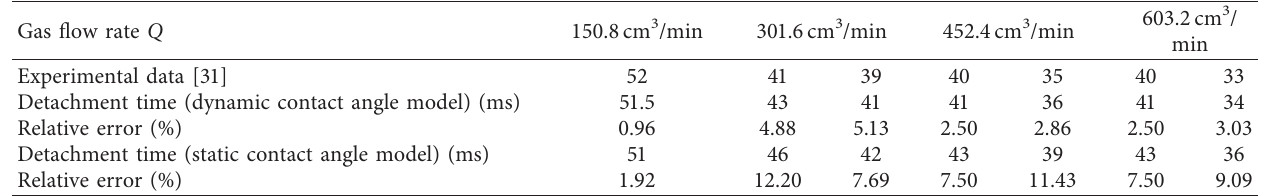
Figure 15: Snapshot comparison of bubble formation ( Q � 603.2cm 3 /min, Re � 219.07, and d � 4mm): (a) experimental snapshots [31]; a (b) results of dynamic contact angle model simulation ( θ A � 130 ° and θ R � 84 ° ); (c) results of static contact angle model simulation ( θ C � 100 ° ). Table 2: Detachment time and relative error for dynamic and static contact angle models.